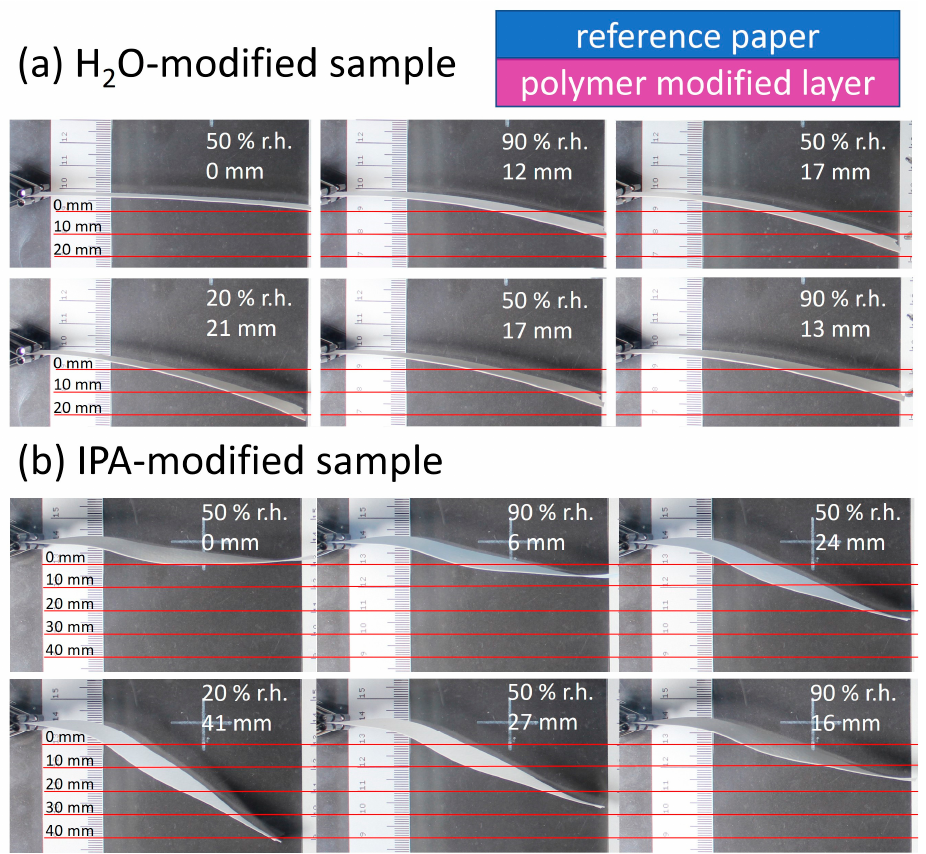
Figure 10. First humidity cycle showing the deflection of the humidity-responsive paper samples (eucalyptus 150 g m − 2 ) with copolymer applied from ( a ) H 2 O and ( b ) IPA, polymer modified “layer” pointing down, in the closed chamber with semi-quantitative analysis of the change of deflection. After each humidity change, the samples were acclimated for 2 h to reach equilibrium.